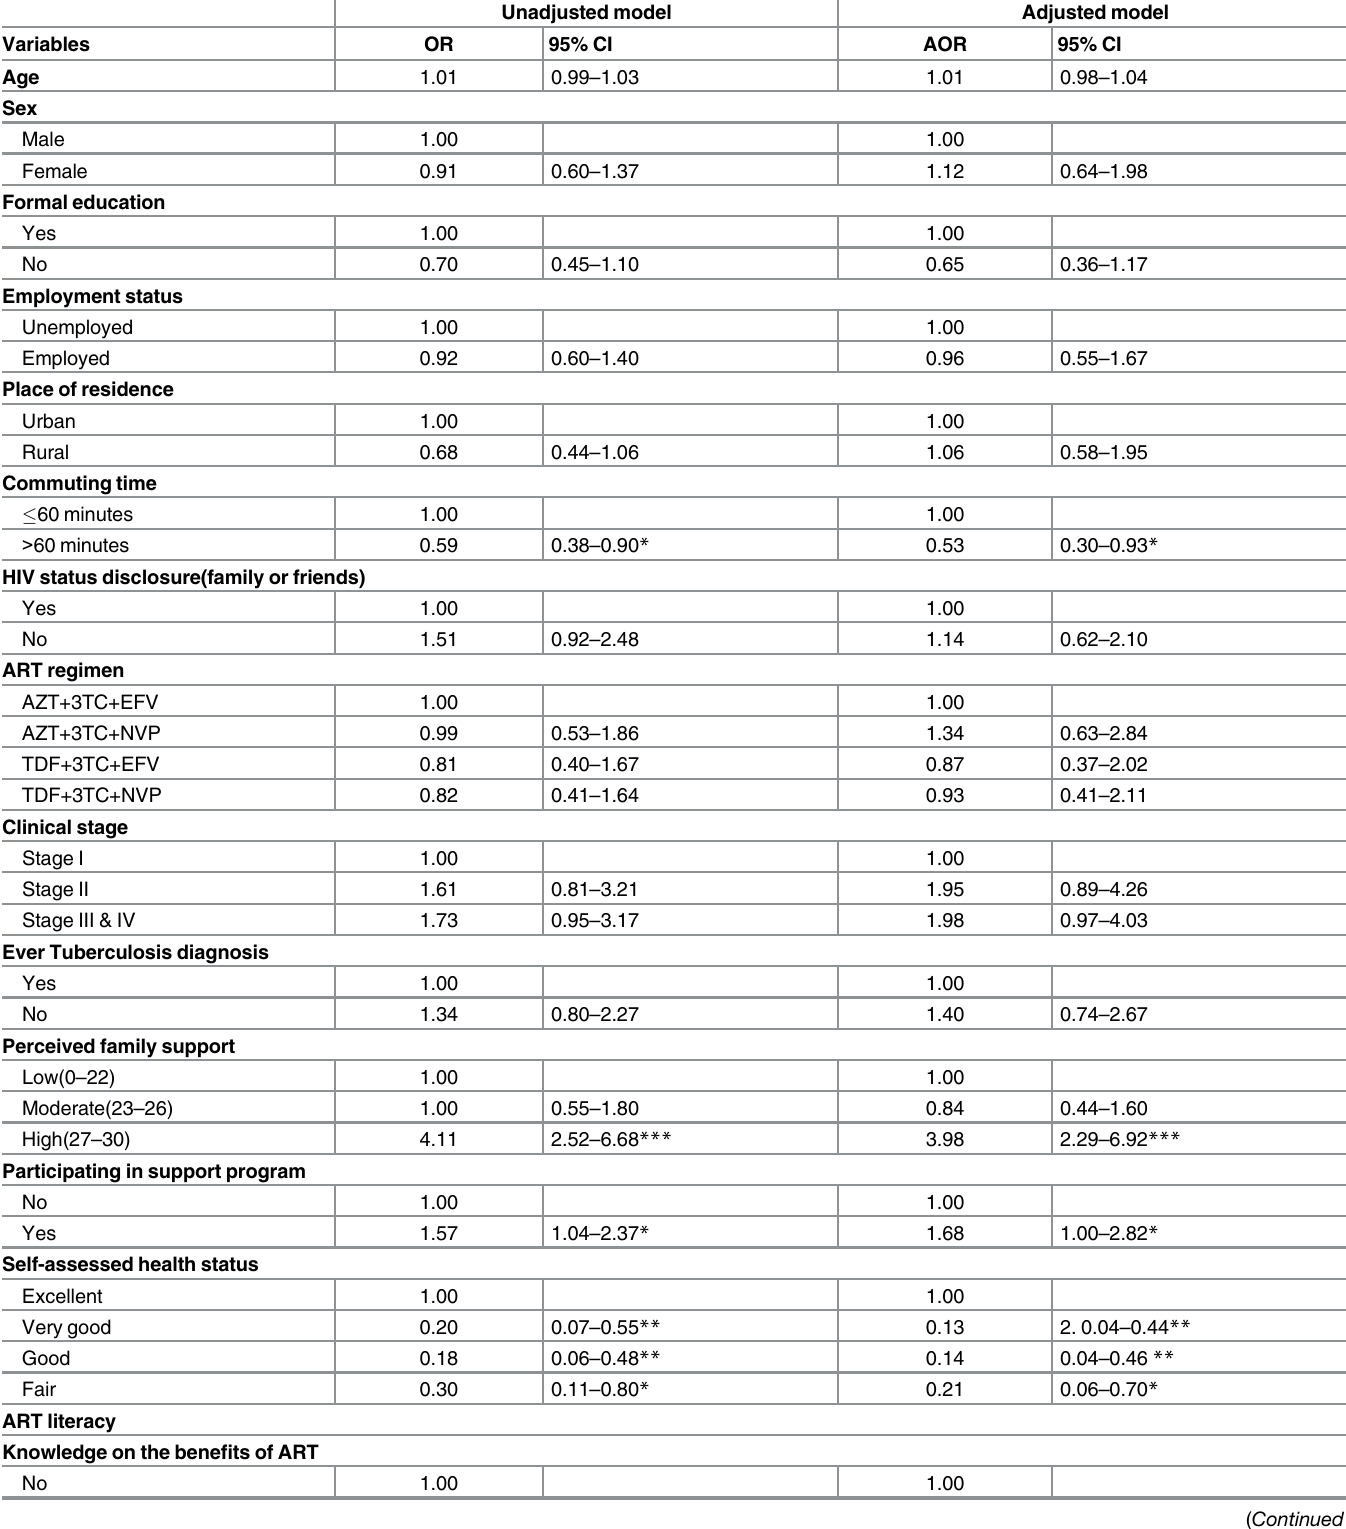
Table 3. Factors associated with regular clinic attendance for pills pick-up among the people living with HIV in